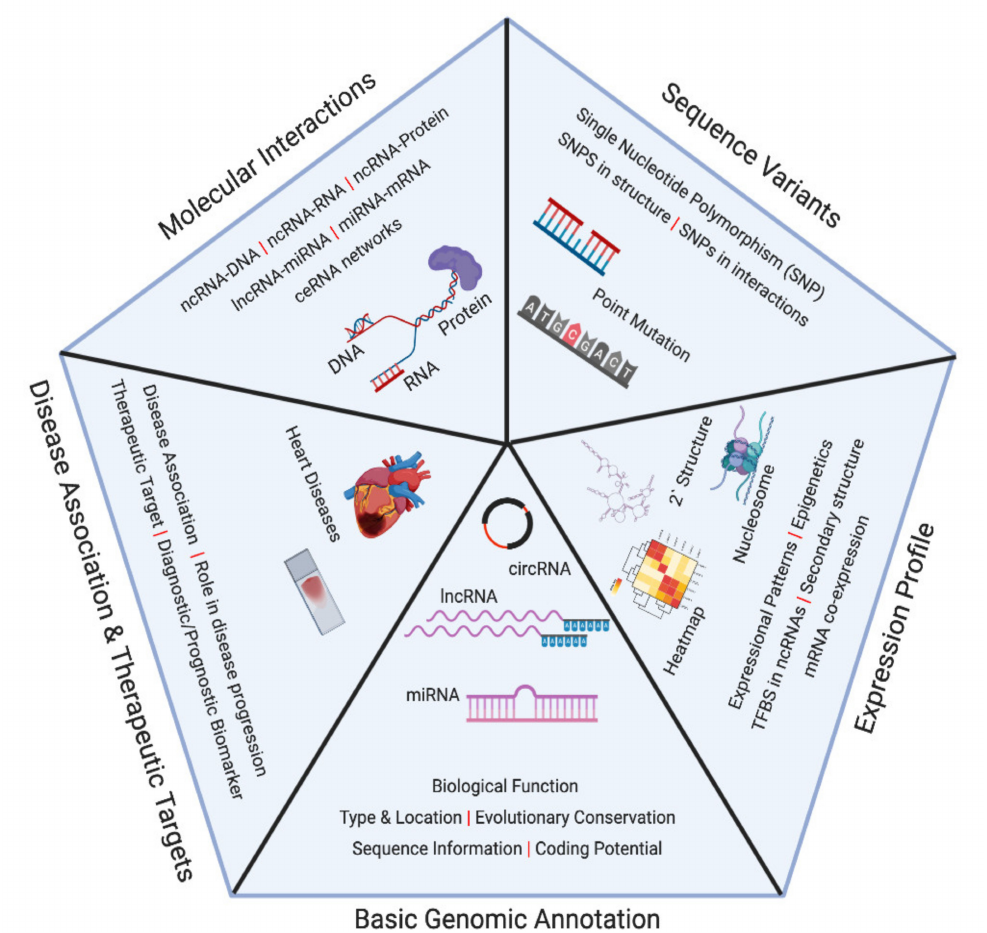
Figure 1. Segregation of information curated on various non-coding RNA databases. The available data have been grouped into five categories: basic genomic annotation, expression profile, molecular interactions, Disease association and therapeutic targets, and sequence variants. Databases for each of these kinds of information are listed in Figure